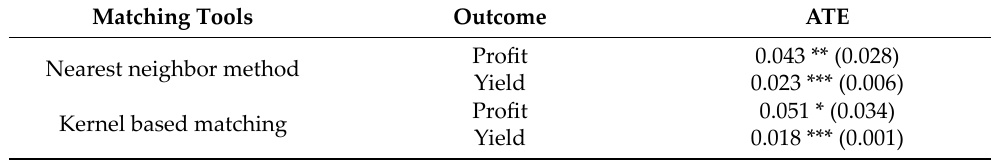
Table 5. PSM estimate for impact of MSC participation on profitability and mandarin yield. Matching Tools Outcome ATE Nearest neighbor